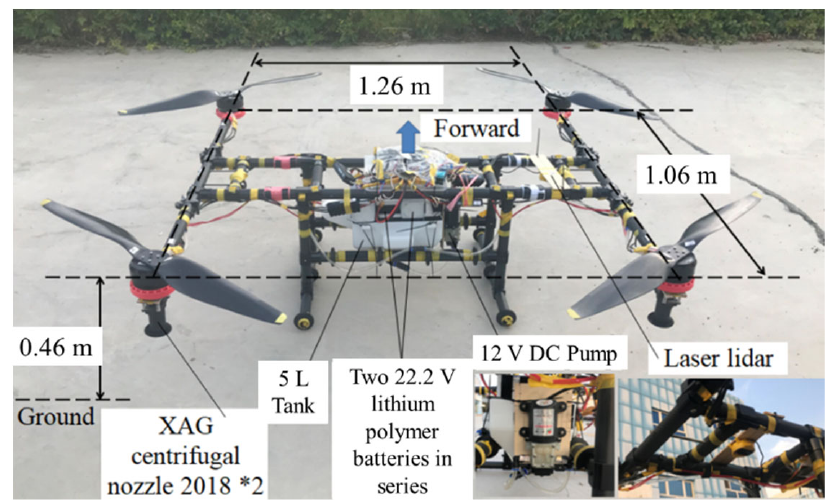
Figure 5. Illustration of dimensions and modules. An electric wiring diagram of the electrical and control system is shown in Figure 6.